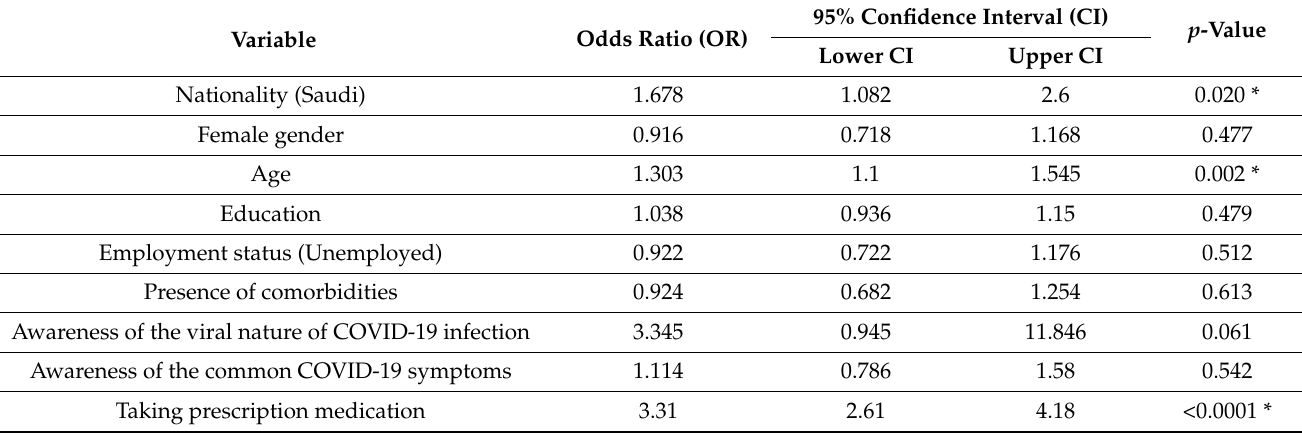
Table 2. Multiple logistic regression analysis for the use of